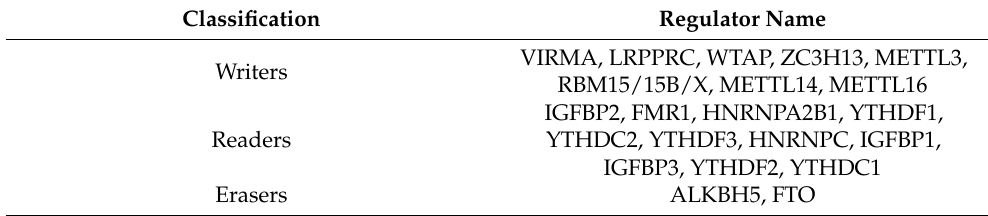
Table 1. M6A regulators included in